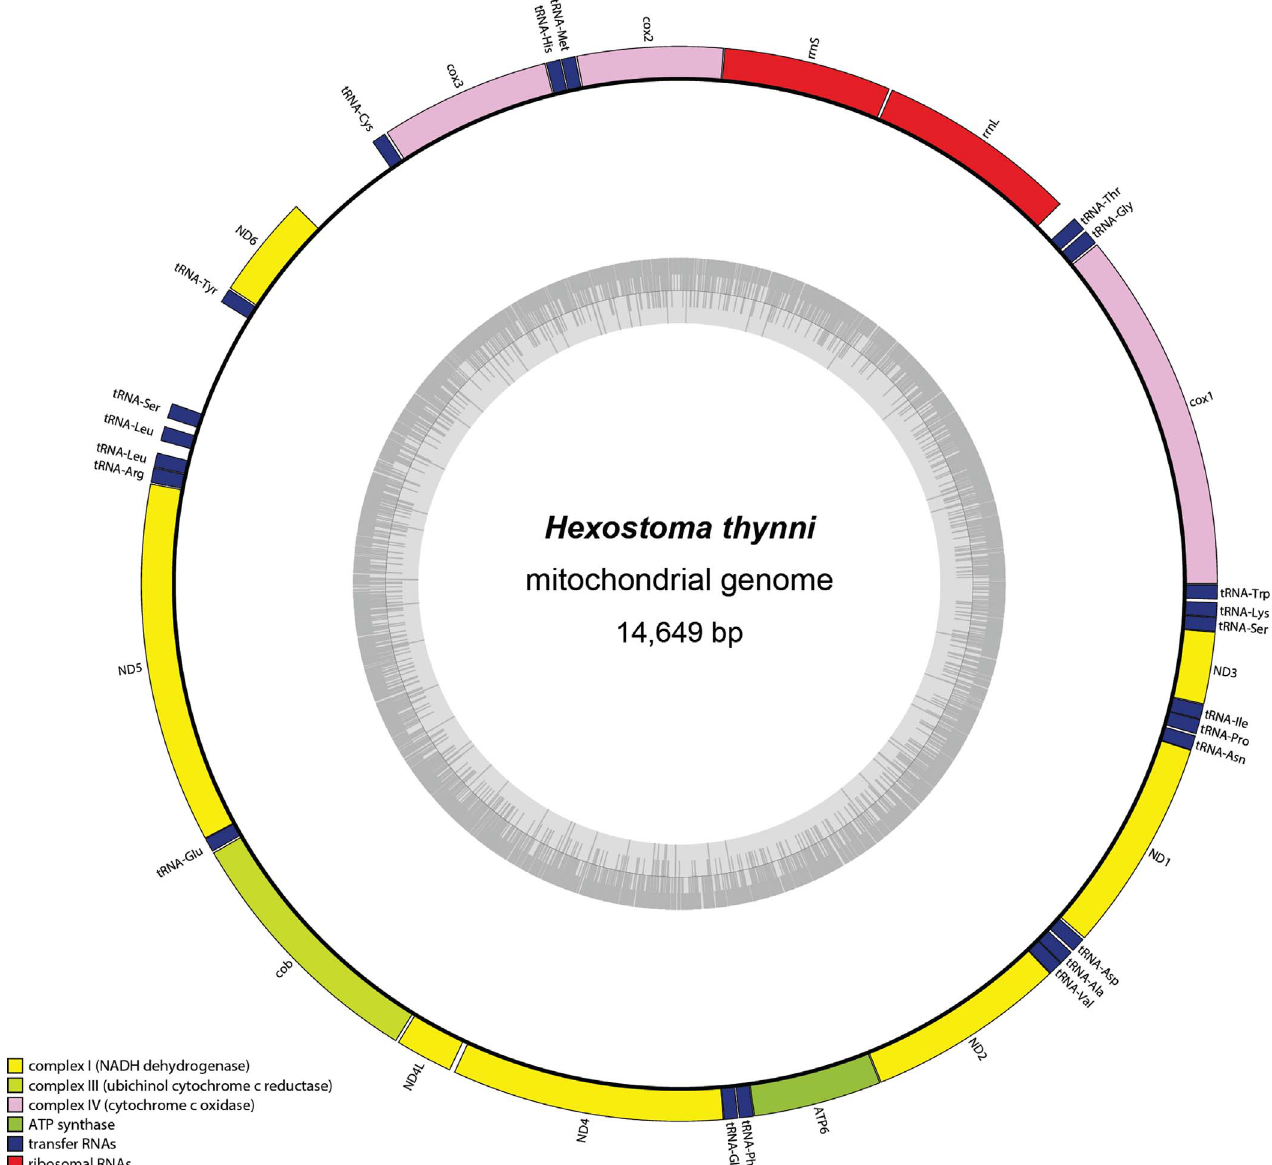
Figure 4. Complete mitogenome of Hexostoma thynni , specimen MNHN HEL1757 from off Algeria. The mitogenome is 14,649 bp long and codes for 12 protein-coding genes, 2 ribosomal RNA genes, and 22 transfer RNA